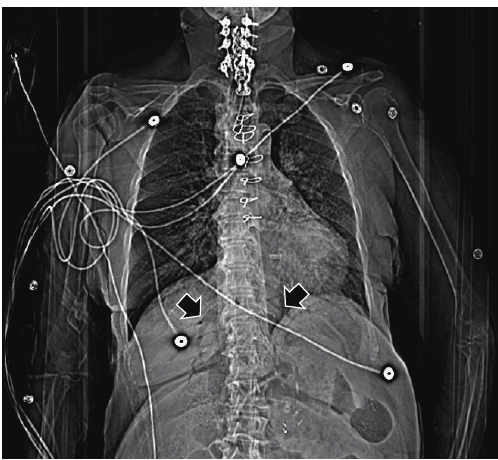
Figure 1: Scout film delineating the hepatic venous system sec- ondary to air contrast ( arrows ).